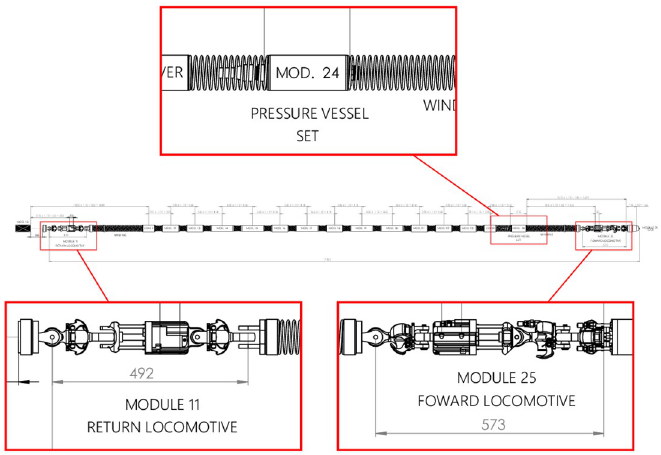
Fig 2. Annelida’s schematic diagram. The representation of one of the pressure vessel set (top), the others (modules 01 to 10) are not represented in this schematic, and traction systems (below).